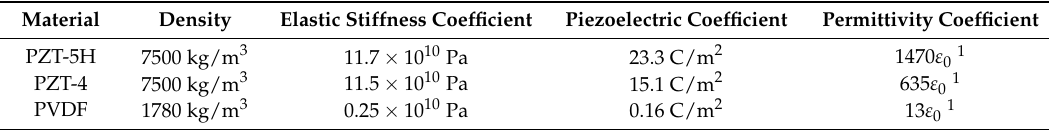
Table 3. Properties of piezoelectric materials.